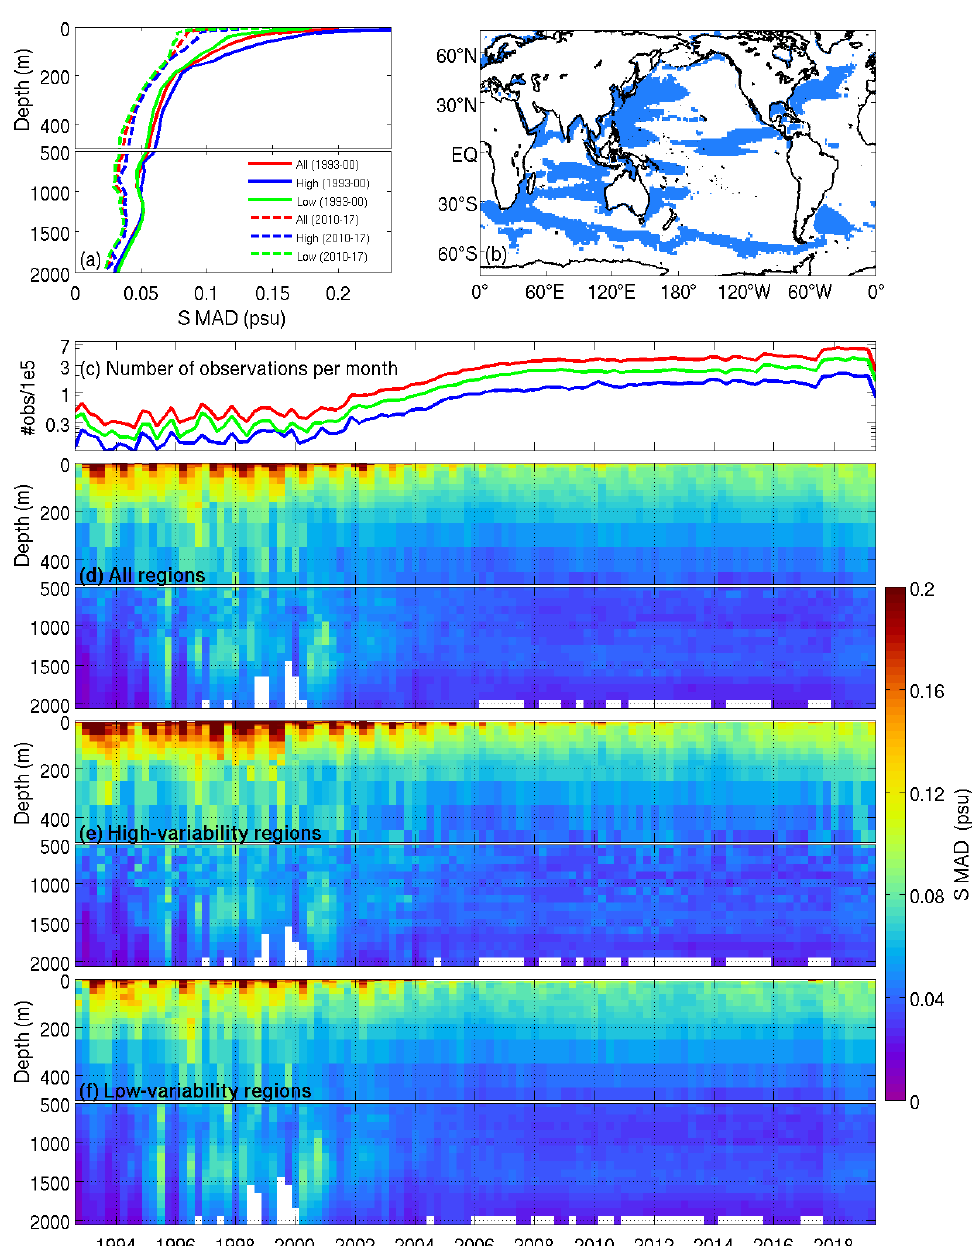
Figure 8. Mean absolute deviations (MADs) of salinity with depth over the course of BRAN2020. Same layout as in Fig.